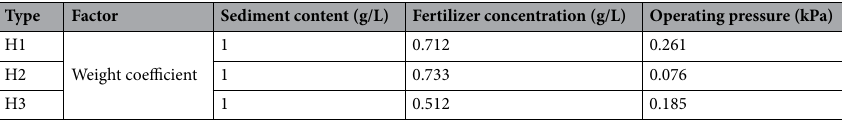
Table 5. Weight coefficients of influencing